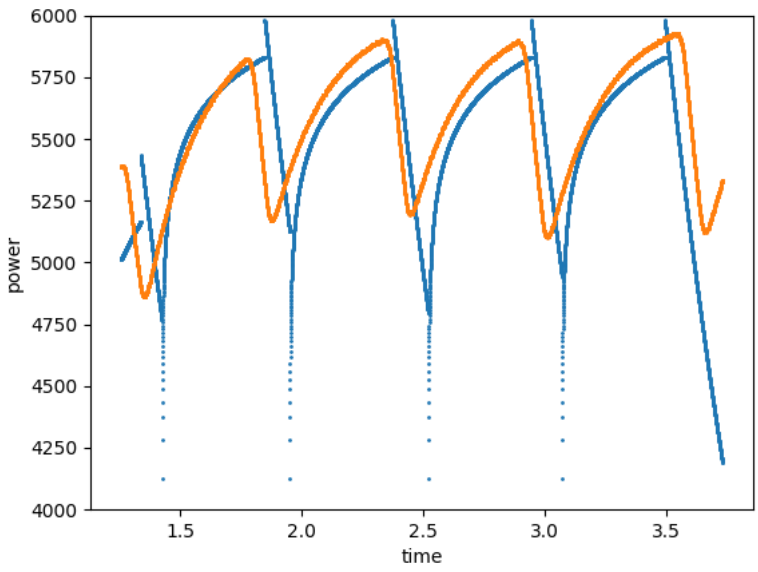
Figure 14. Profile estimated by the llinear regression.